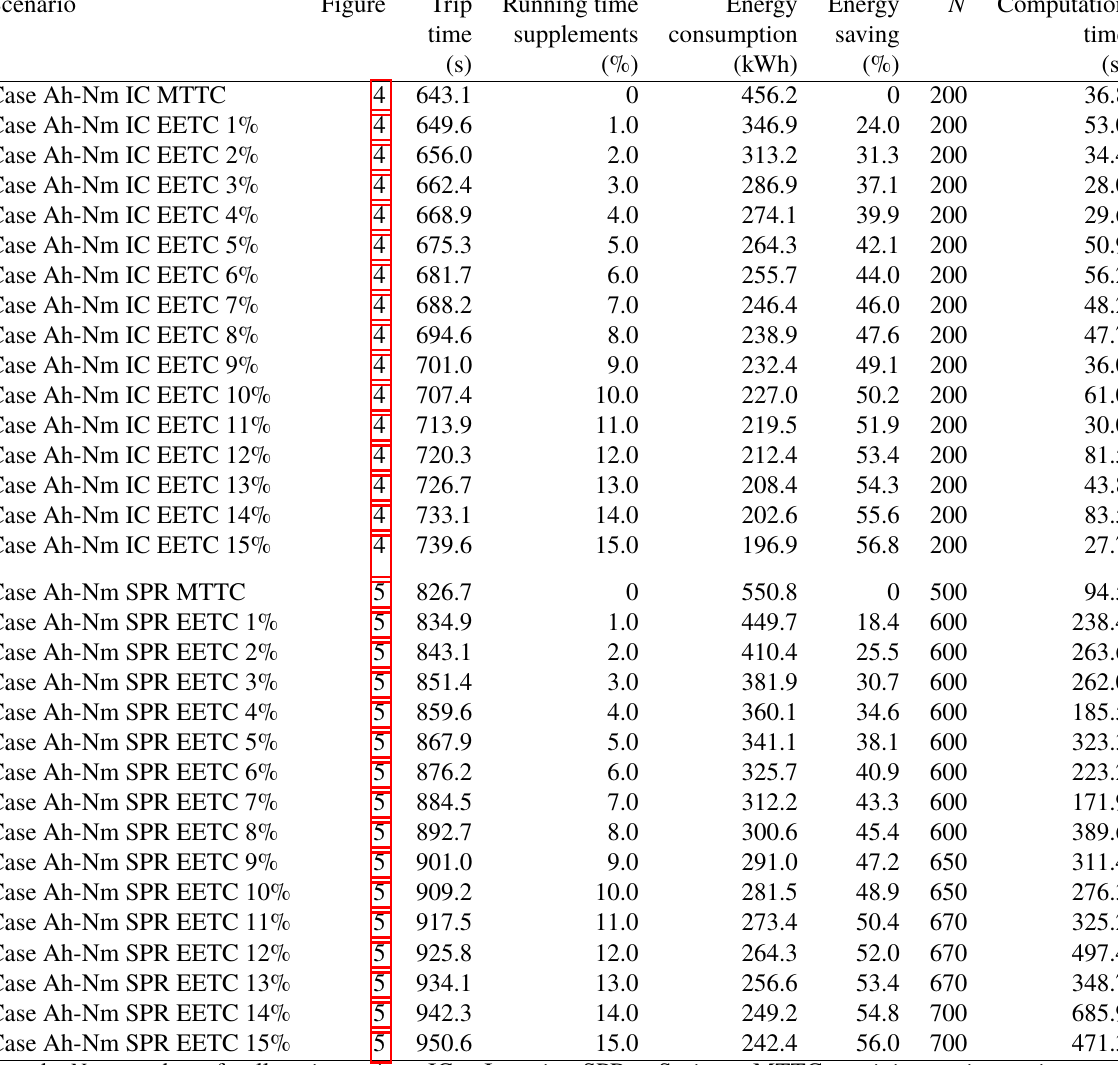
Table 9: Results of the different driving strategies with varying running time supplements of the IC and SPR for the real-world case